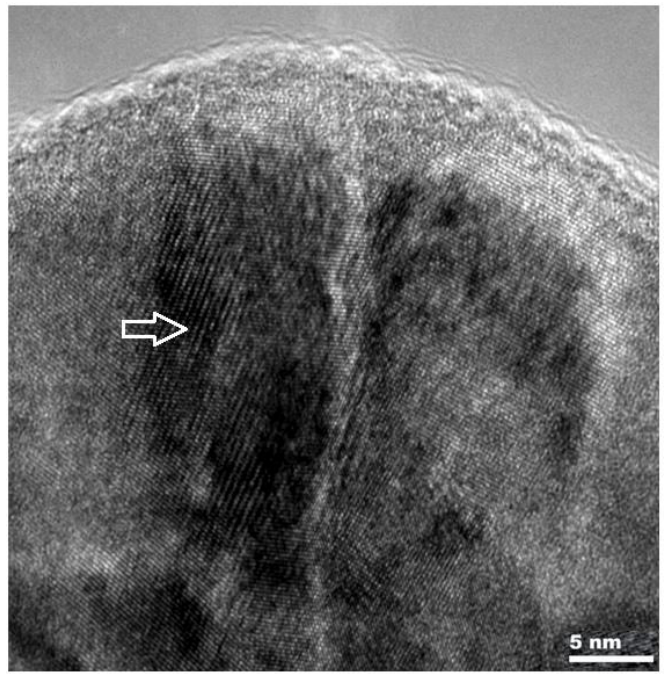
Figure 2. Microstructure of the composite nc-TiN/a-Si 3 N 4 layer, obtained on a high-resolution elec- tron microscope. White arrow shows TiN nanocrystalic area (ribbed), remaining area is amorphous silicon nitride—Si 3 N 4 .